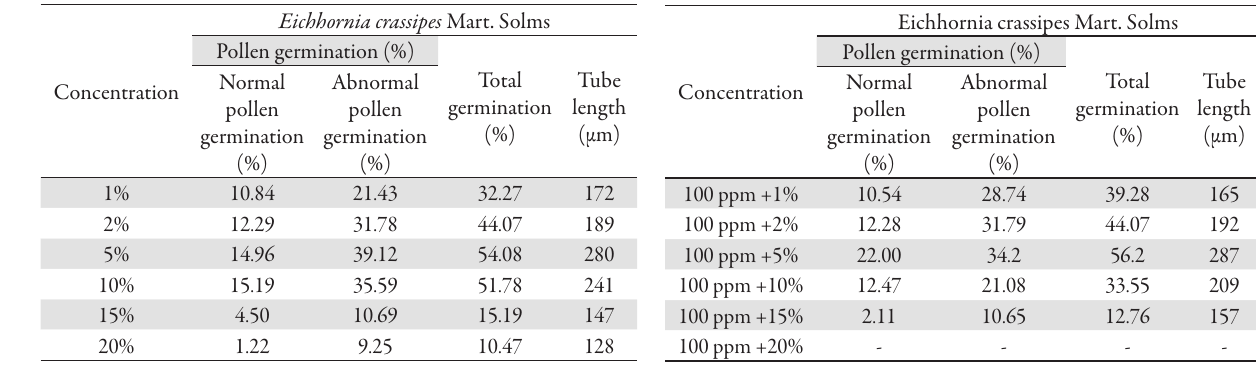
Tab. 1. Effect of sucrose solution in pollen germination of Tab. 2. Effect of boric acid and sucrose solution in